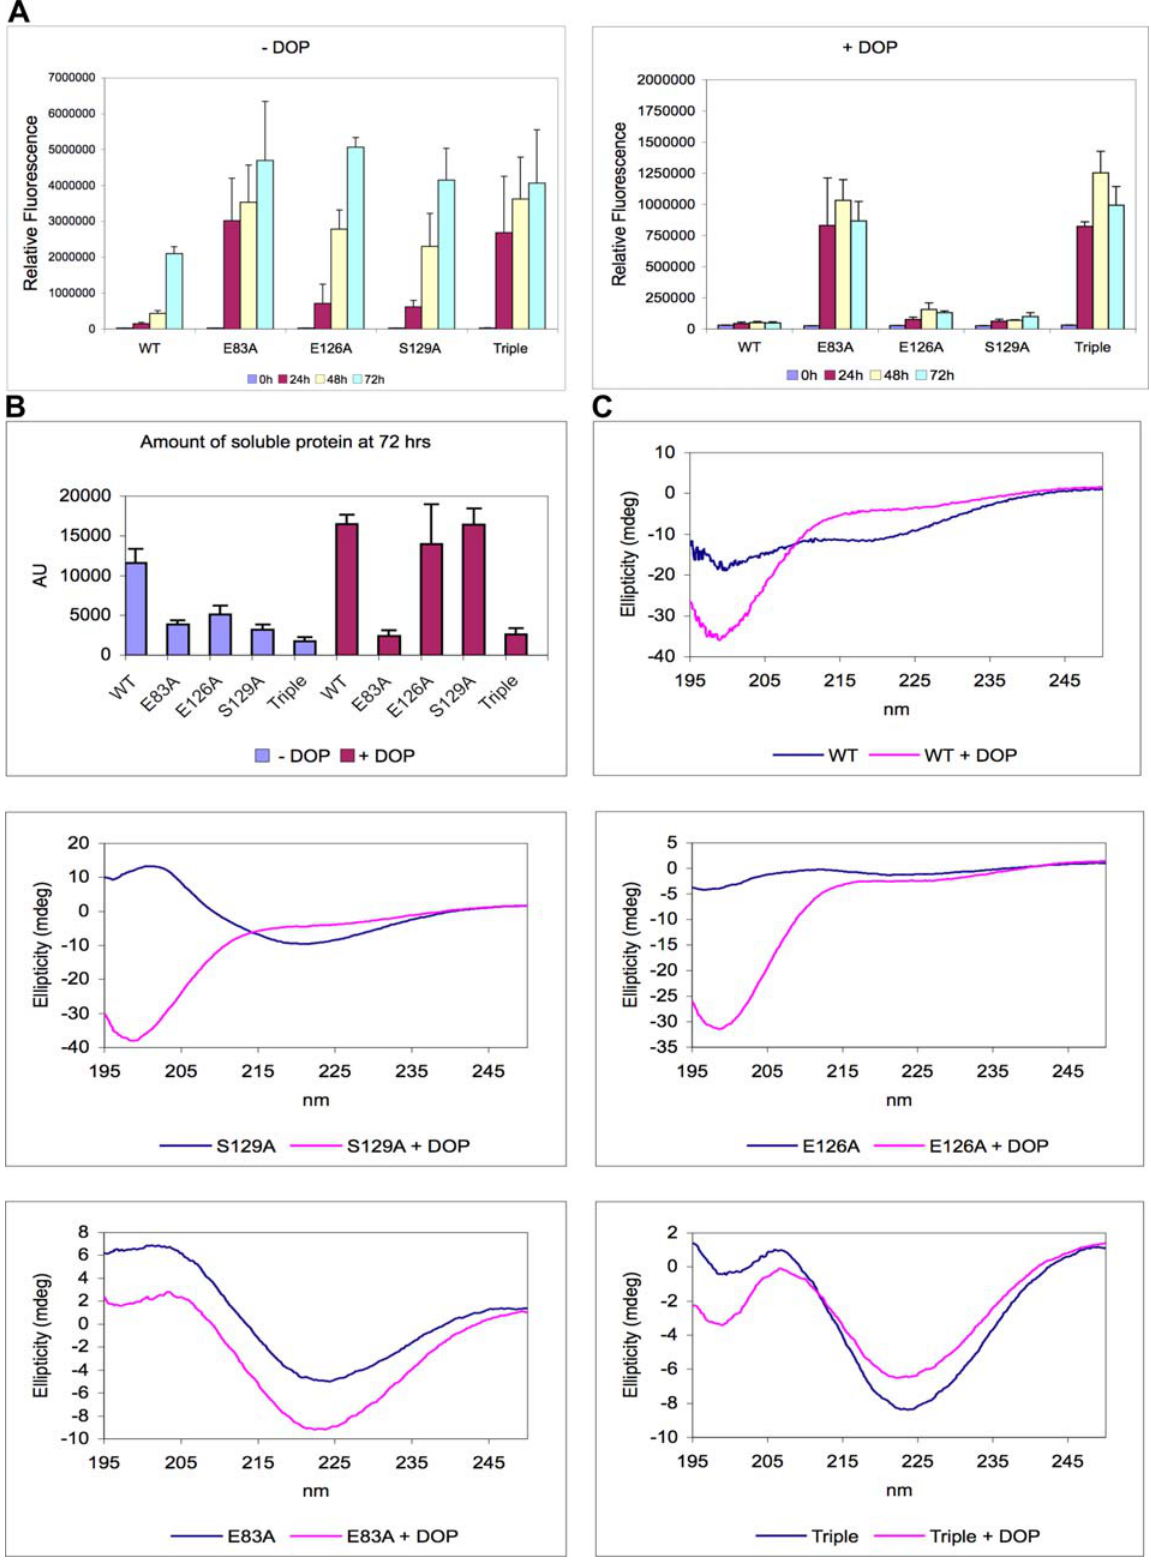
Figure 3. Invitro fibrillization of a -synuclein . (A) Kinetics of fibrillization of WT and mutant (E83A, E126A, S129A and Triple) a -synuclein under assembly conditions in absence or presence of an equimolar quantity of dopamine (DOP) as monitored by the enhancement in Thioflavin-T (ThT) fluorescence intensity over time. Data are expressed as the mean 6 SEM (Standard Error of the Mean) of 2 or 3 independent experiments. (B) Amount of soluble WT and mutant a -synuclein protein remaining in solution after 72 hrs incubation under assembly conditions in absence or presence of an equimolar quantity of DOP monitored by SDS-PAGE. (C) CD spectra of the soluble WT and mutant a -synuclein proteins remaining in solution after 72 hrs incubation under assembly conditions in absence (blue line) or presence (red line) of an equimolar quantity of DOP.